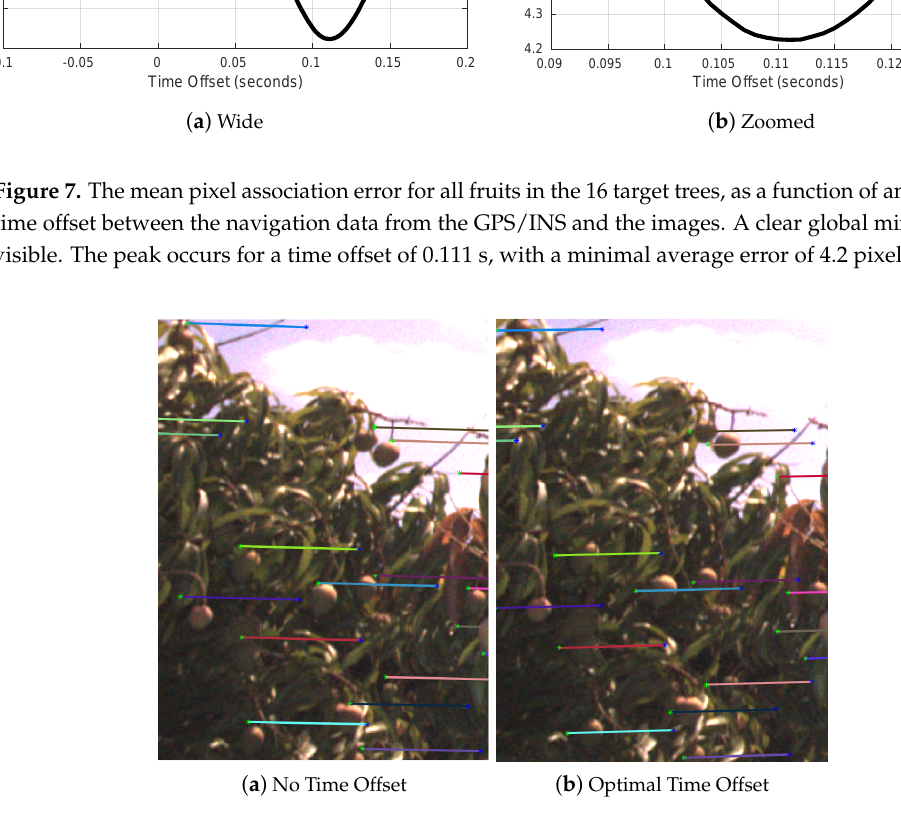
Figure 8. An example of projecting epipolar line segments from one image to the next, with and without the optimised time offset: ( a ) no offset is applied; ( b ) the optimal offset of 0.111 s is applied. The average error reduced from 11.4 to 4.2 pixels, which agrees with the magnitude of errors in this